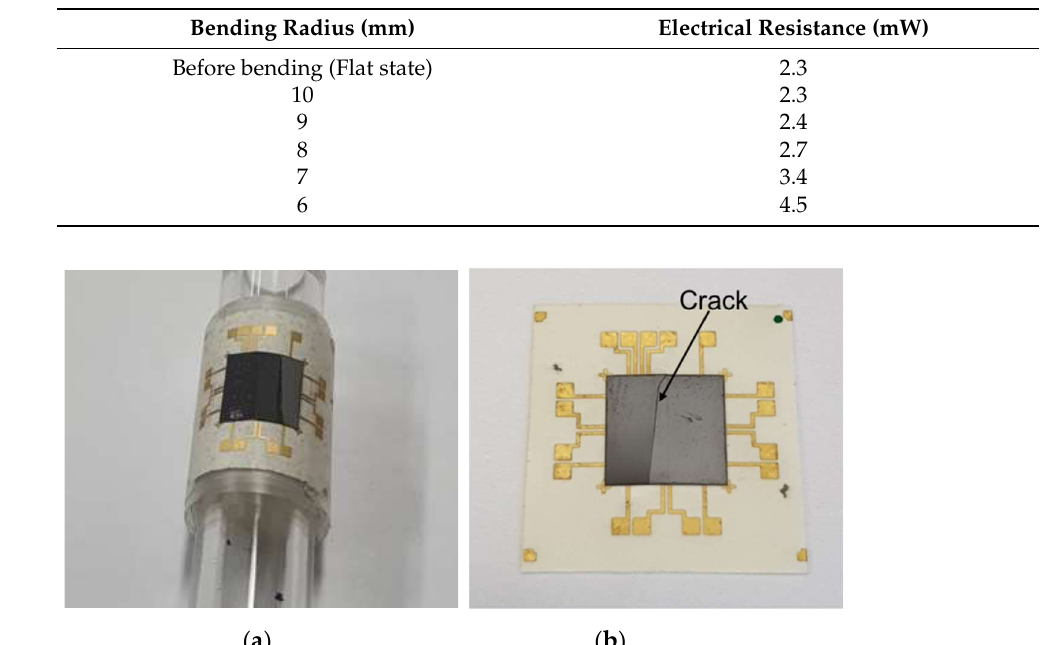
Figure 17. Maximum stress of the silicon chip at a bending radius of 6 mm.